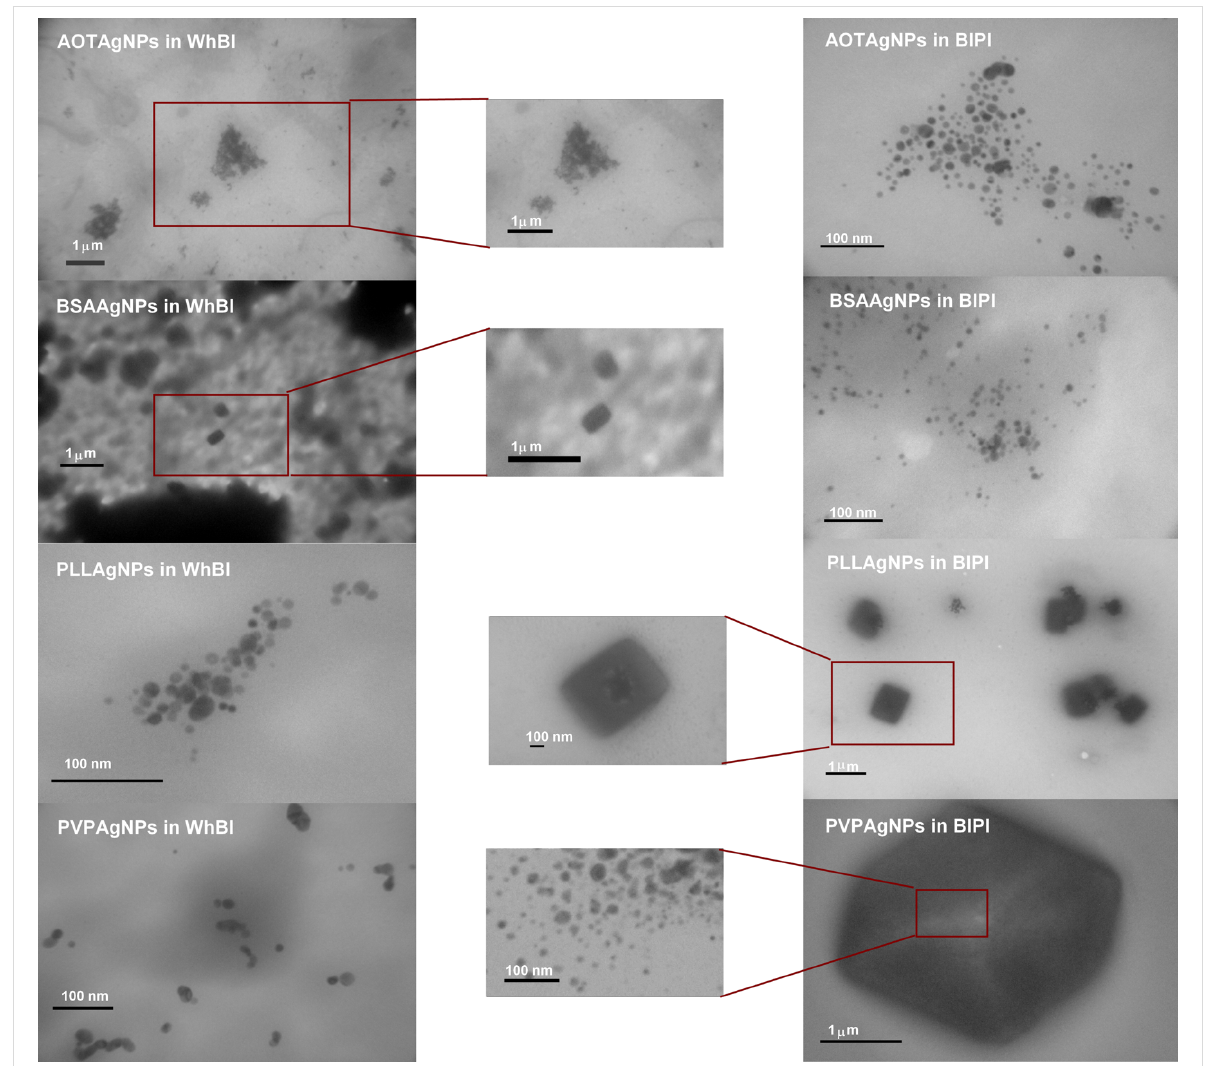
Figure 8: Transmission electron micrographs (TEM) of different silver nanoparticles coated with sodium bis(2-ethylhexyl) sulfosuccinate (AOTAgNP), bovine serum albumin (BSAAgNP), poly(L-lysine) (PLLAgNP), and poly(vinylpyrrolidone) (PVPAgNP) in whole blood (WhBl) and blood plasma (BlPl) of Wistar rats after 1